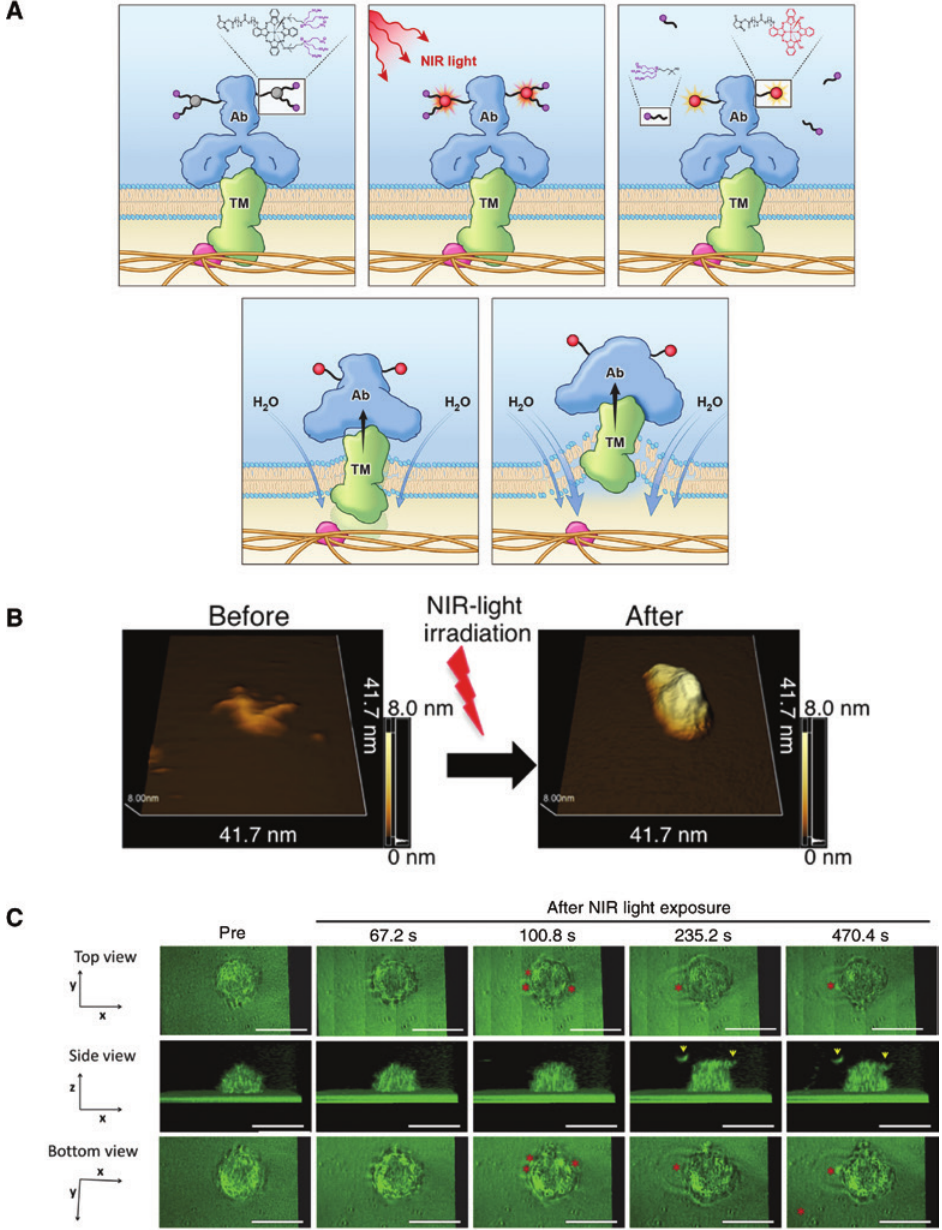
Figure 2 Cell killing mechanism of NIR-PIT. (A) Cell killing mechanism of NIR-PIT. An antibody-IR700-antigen complex is formed on the cell membrane. With NIR light exposure, axial ligands are released from the IR700 molecule. The conformational change of the antibody-IR700-antigen complex may produce physical stress in the cell membrane, resulting in the weakening of the membrane. The water outside of the cell is flown into the cell to burst the cell. Adapted from Ref. [106]. (B) Single-molecule imaging of antibody-IR700 conjugates before and after NIR light exposure. A single molecule of pan-IR700 on mica changes in shape and size after NIR light irradiation. Adapted from Ref. [106]. (C) 3D LC-QPM imaging depicts morphological dynamics. 3T3/Her cells initially swelled, formed blebs, and ruptured after NIR light exposure. Red asterisk indicates a bleb. Yellow arrowhead indicates a flying fragment. Adapted from Ref.